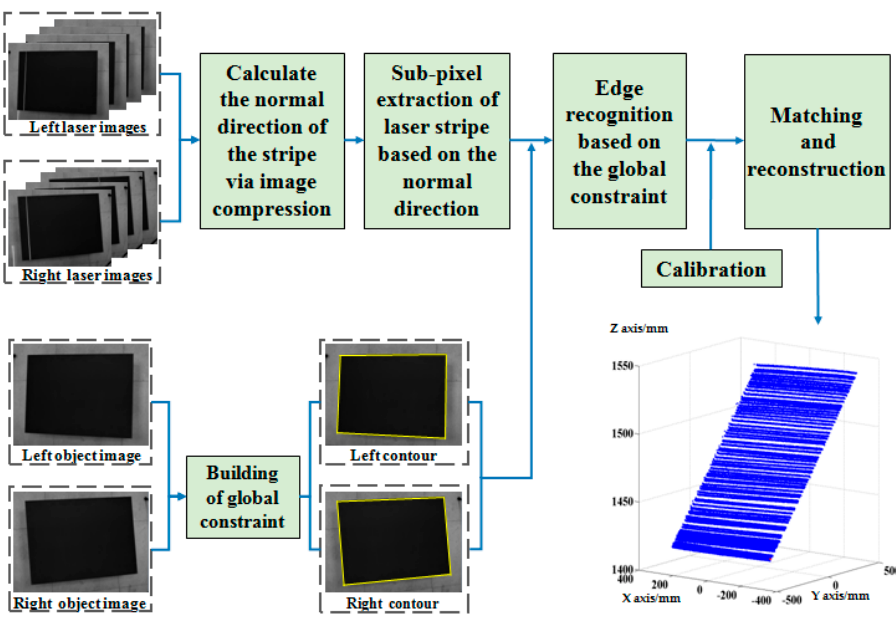
Figure 1. Block diagram of the proposed measuring method.